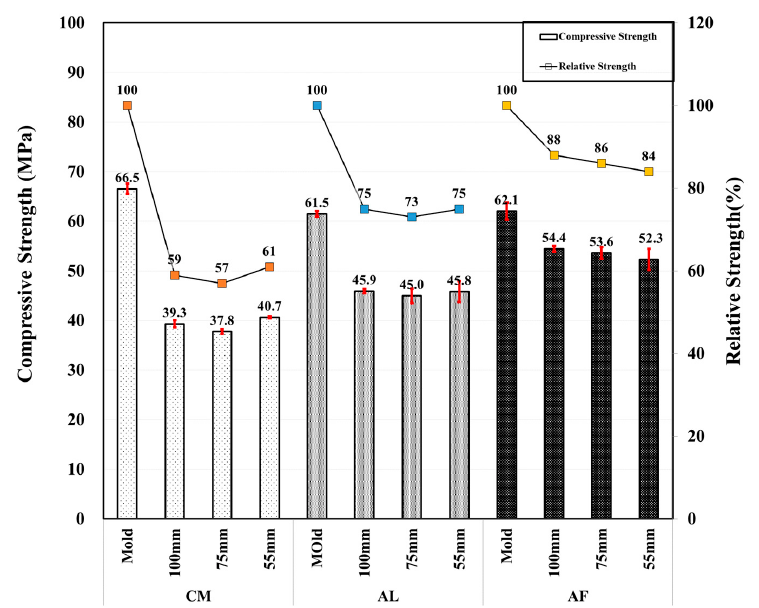
Figure 5. Core compressive and relative strengths of CO and SH specimens by accelerators for 3 month old specimens.